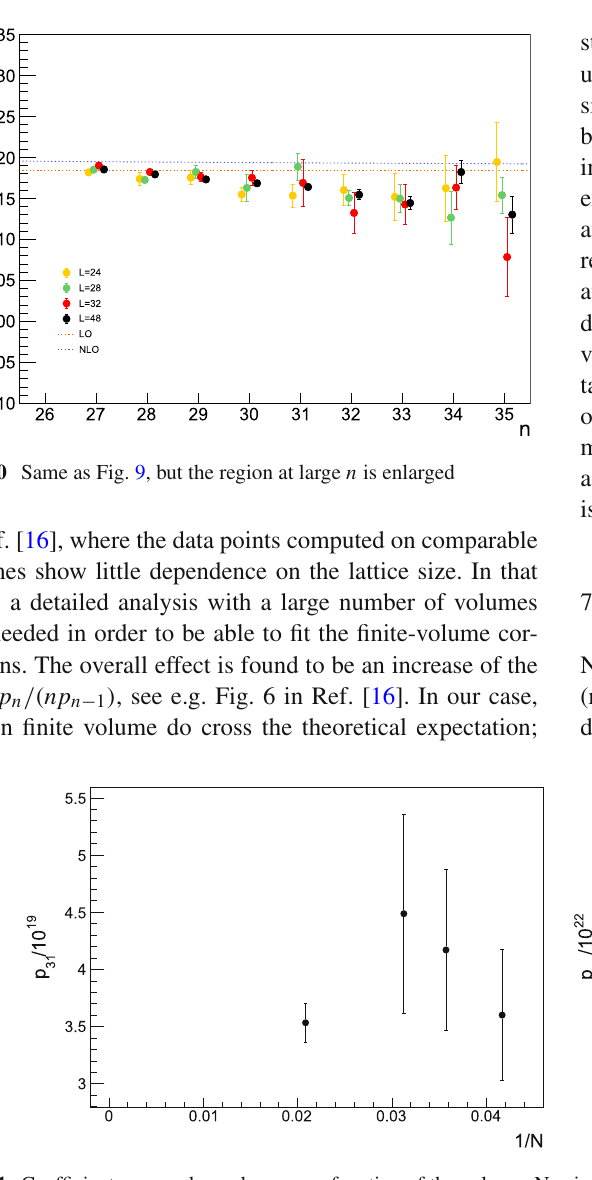
Fig. 11 Coefficients p 31 and p 35 drawn as a function of the volume. No significant finite-volume effects are observed at our level of